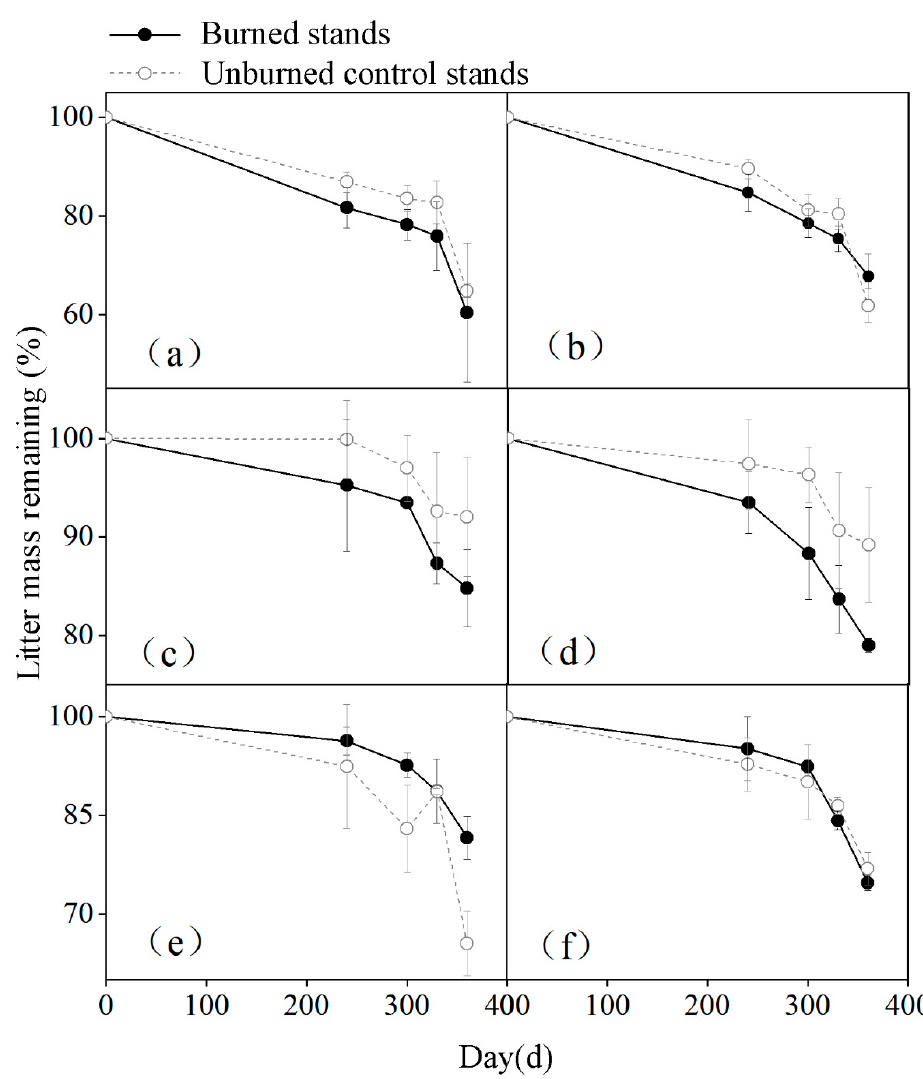
Figure 3. Decomposition of Larix leaf litter in bags placed on the soil surface ( left ) and leaf litter surface ( right ) for one year in burned and unburned control stands at different ages after fire disturbance in a Larix gmelinii forest ( n = 3). Note: The data are the mean ± standard error. ( a , b ) show the surpluses of litter mass after a three-year fire disturbance. ( c , d ) show the surplus of litter mass after a nine-year fire disturbance. ( e , f ) show the litter mass surplus after 28 years of fire disturbance. On the left is the upper litter layer, and on the right is the lower litter layer.